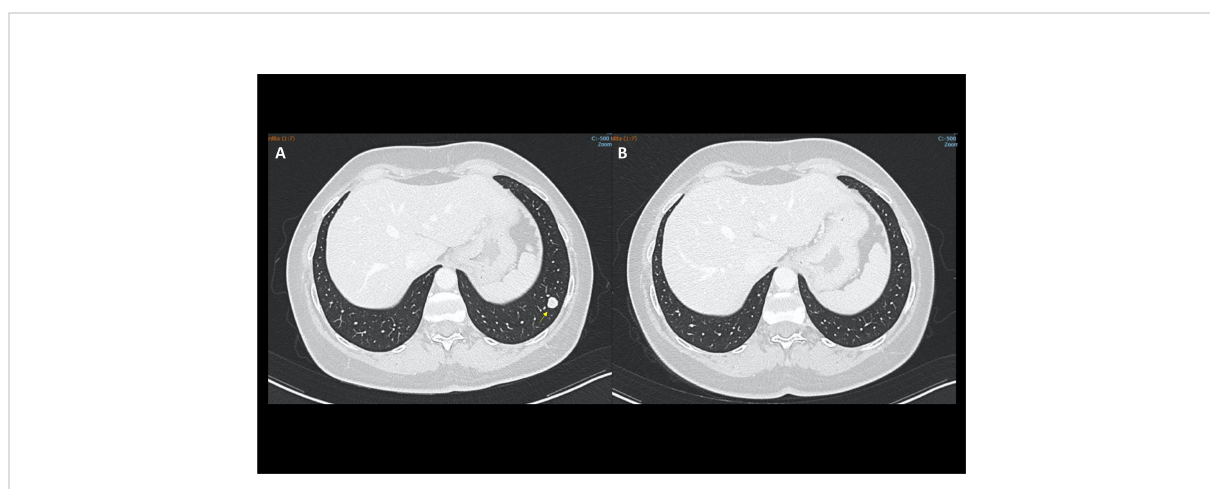
FIGURE 1 Case 1, CT scan showing a signi fi cant shrinking in the left lung lower lobe (arrows) from December 2021 (A) to May 2022 (B)